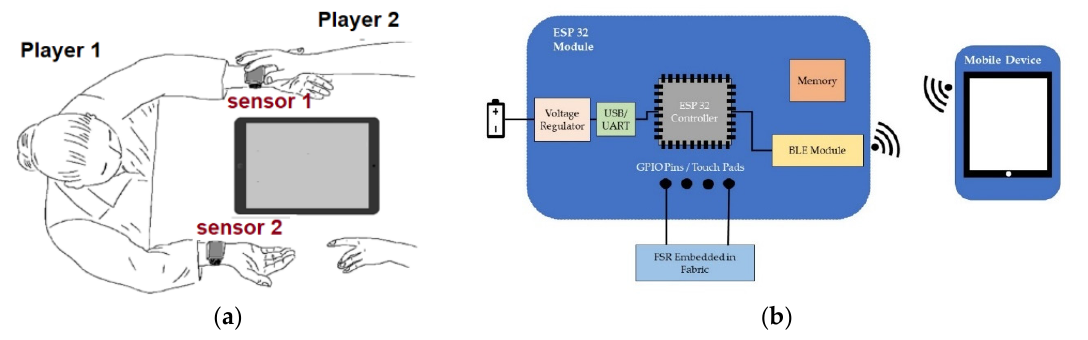
Figure 1. ( a ) Mechanism of gameplay using wearable sensors functionalized with FSRs; ( b ) block diagram of the proposed wearable sensor communicating wirelessly with a mobile device.